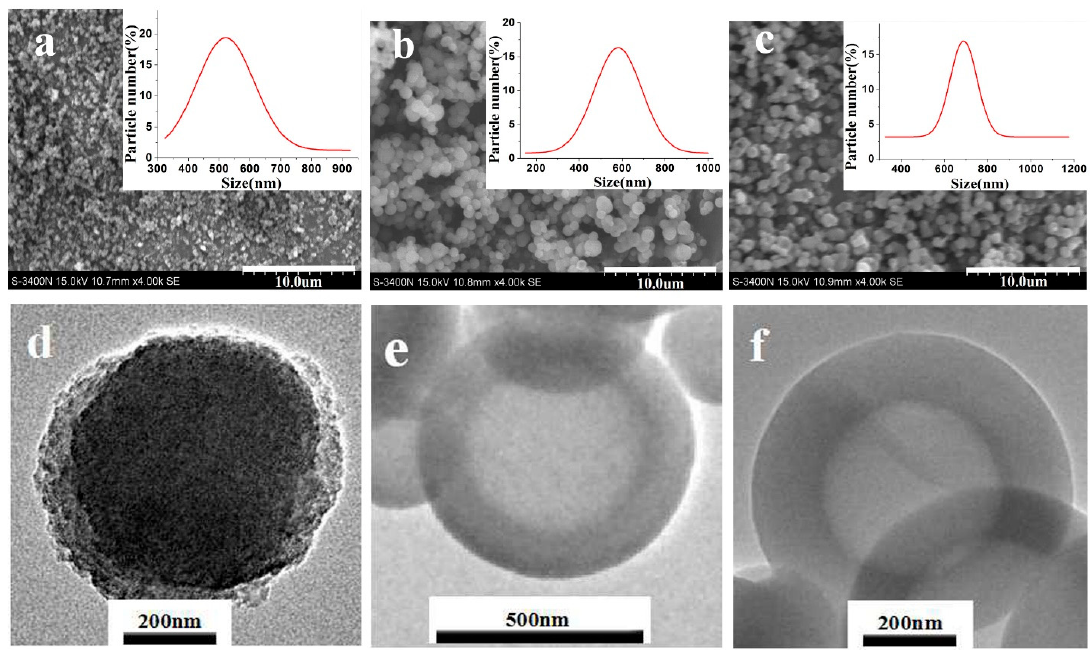
Figure 2. SEM images of ( a ) APTES-modified, ( b ) MPTES-modified, and ( c ) GPTES-modified SiO 2 nanospheres; TEM images of ( d ) APTES-modified, ( e ) MPTES-modified, and ( f ) GPTES-modified SiO 2 nanospheres; the insets in the SEM images are the particle size distributions of SiO 2 nanospheres modified by di ff erent functional